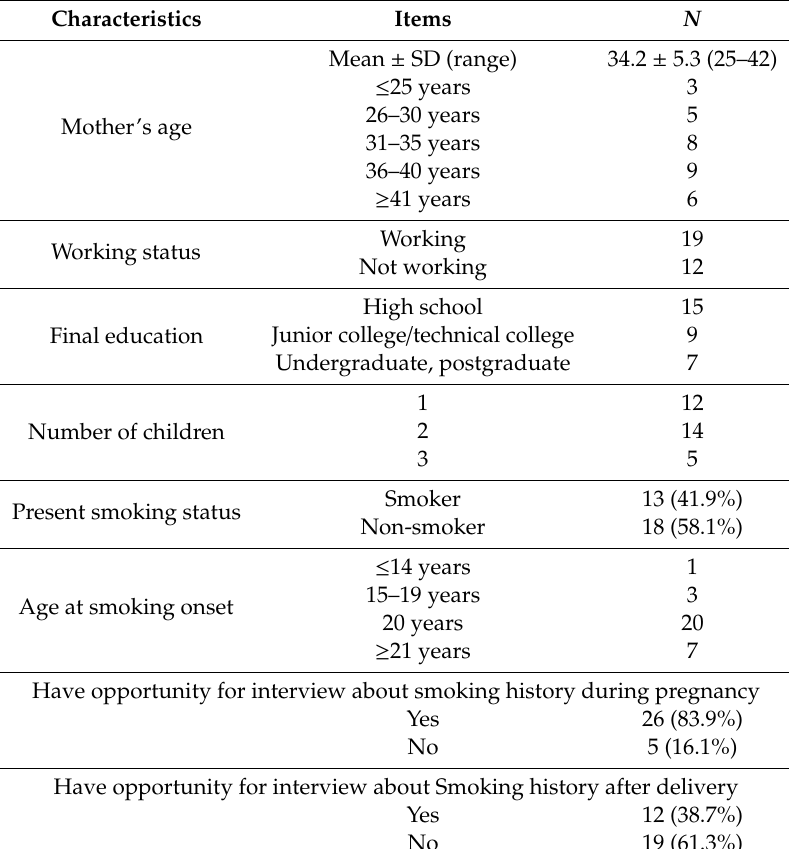
Table 1. Characteristics of the participants ( N =